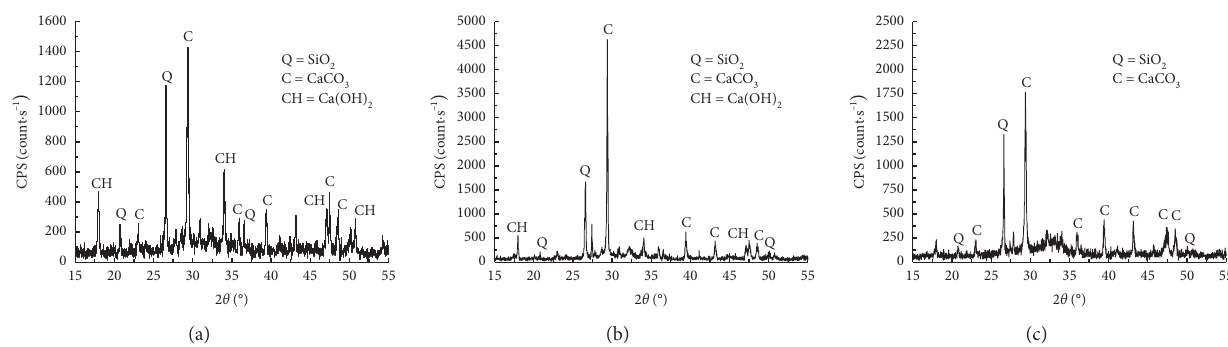
Figure 23: X-ray diffraction analysis of DSRR-60% after different temperatures. (a) Room temperature. (b) 300 ° C. (c) 700 ° C.